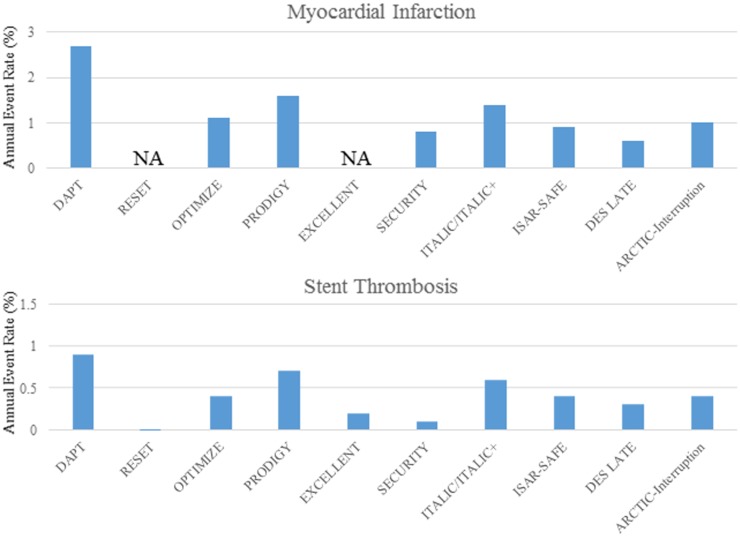
Estimated annual event rates for myocardial infarction and stent thrombosis in the short-DAPT group during aspirin mono-therapy.The landmark data was not available for myocardial infarction in the RESET and EXCELLENT trials. NA = not available.